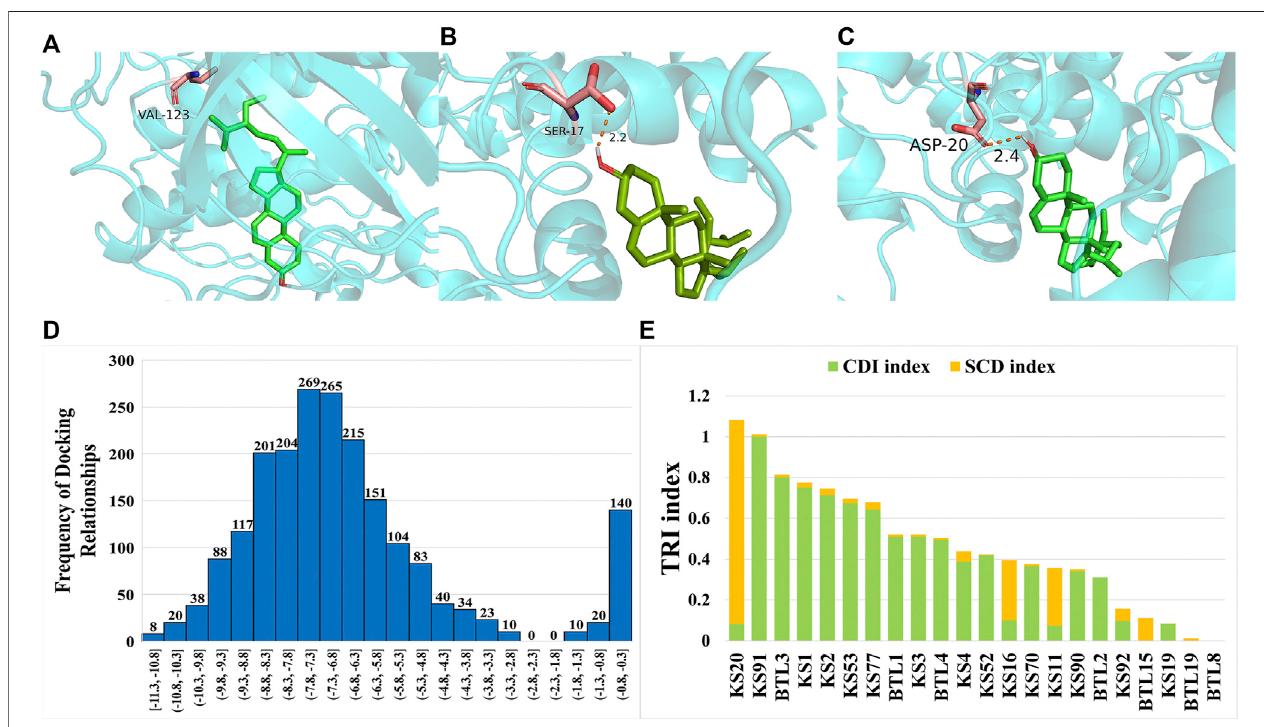
FIGURE 7 | (A) Docking result visualization of BTL3-3ovv (coded by PKA). (B) Docking result visualization of BTL4-2w73 (coded by CaM). (C) Docking result visualization of BTL3-2w73 (coded by Cam). (D) The frequency histogram of the af fi nity value. (E) The bar plot to display the composition of CDI and SCD in each TRI.